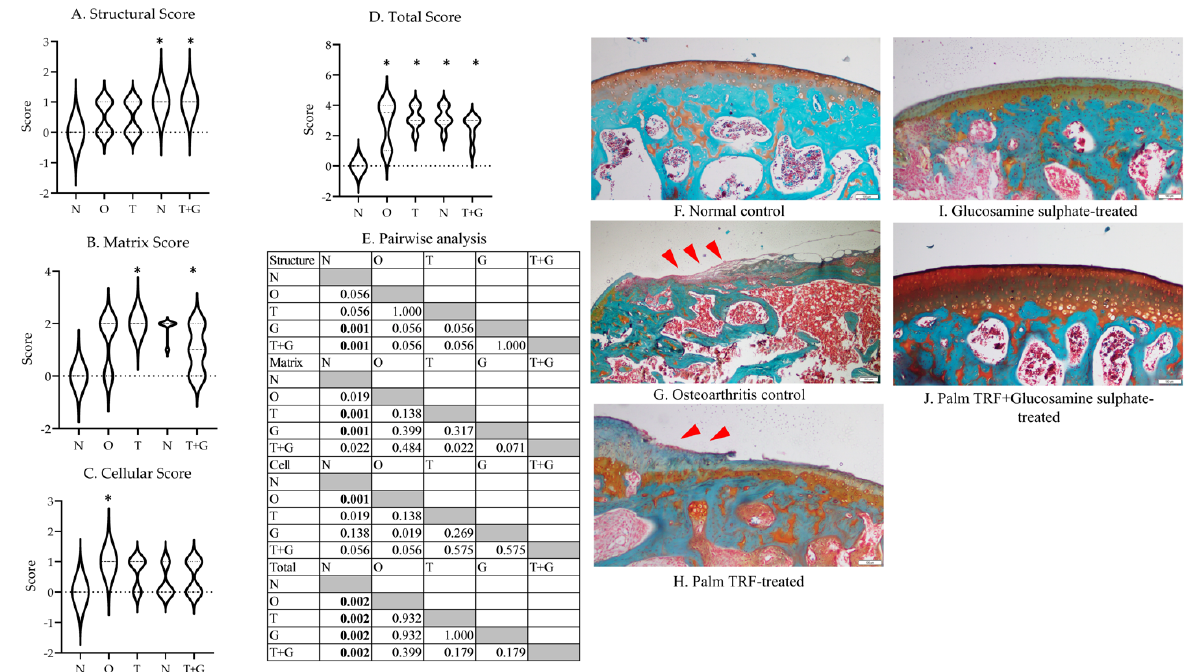
Figure 4. Mankin’s score (range of scores in violin plot) for the cartilage structure of the rats ( A – D ). The results of inter-group comparison ( p -values) obtained from the Mann–Whitney U-test are depicted in ( E ). The significant difference is defined at p < 0.005 after Bonferroni correction. The representative photomicrographs (magnification: 20 × ) of each group are presented in ( F – J ) (( F ): normal control; G : osteoarthritis control; ( H ): palm TRF-treated group; ( I ): glucosamine sulphate-treated group; ( J ): palm TRF + glucosamine sulphate-treated group). Significant cartilage deterioration (red arrow heads) was observed for the O group, and lesions were still observed for all treated groups. Abbreviation: *: significant difference compared to the N group; N: normal control; O: osteoarthritis control; T: palm TRF-treated group; G: glucosamine sulphate-treated group; T + G: palm TRF + glucosamine sulphate-treated group.